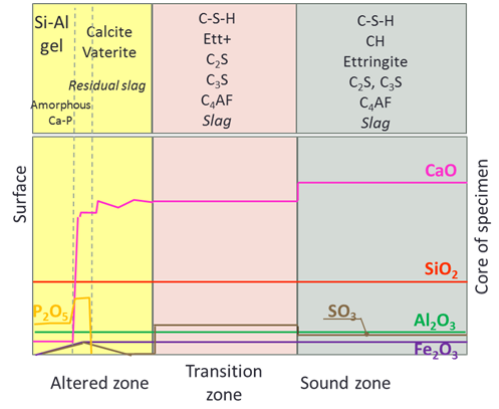
Figure 3. Typical mineralogical and chemical changes in CEM I and CEM III cement paste specimens (W/C=0.4) exposed to the liquid phase of a lab digester (see chemical conditions in text). This diagram synthetizes data from EPMA, XRD and SEM ‐ EDS analyses. Ett+: secondary non ‐ harmful ettringite precipitated in transition zone. For CEM I paste, the thickness of the altered zone and of the transition zone were 300  m and 400  m, respectively, after 5 weeks of exposure